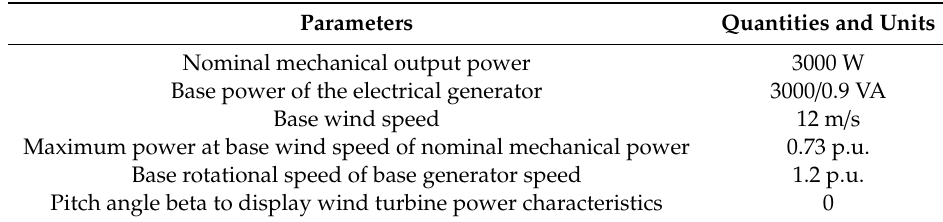
Table 1. Parameters of wind turbine in this study.